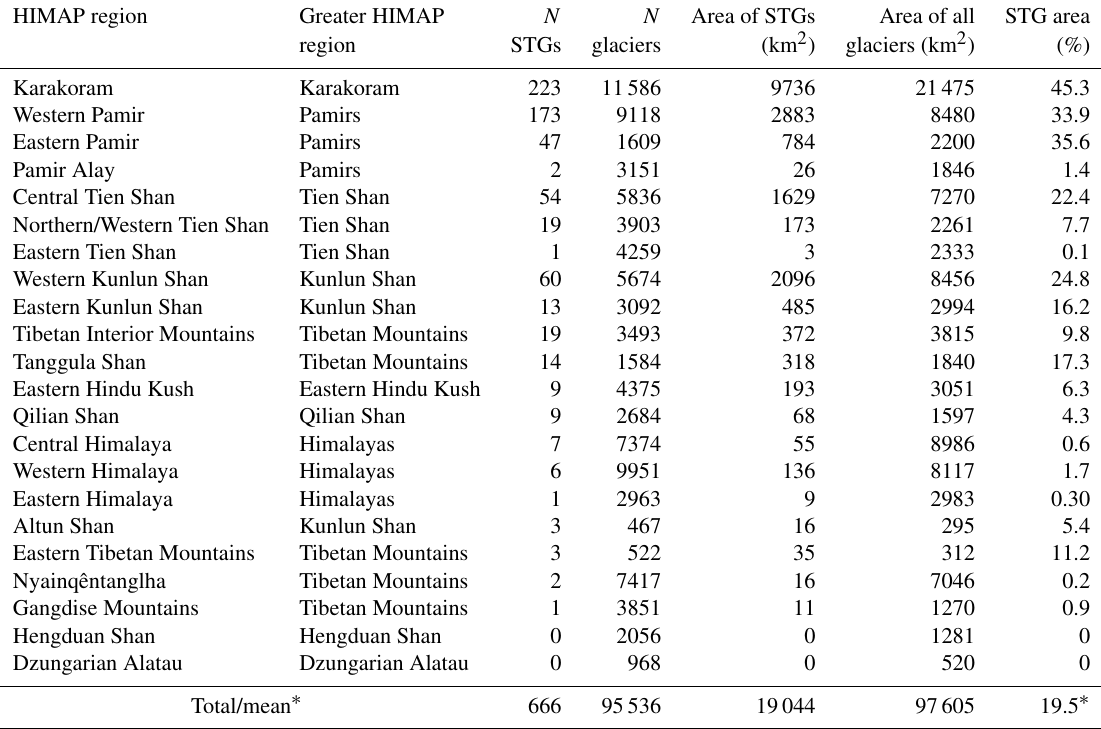
Table 1. Table of number and proportion of area covered by RGI polygons of surge-type glaciers for each HIMAP region (Bolch et al., 2019). STG: surge-type